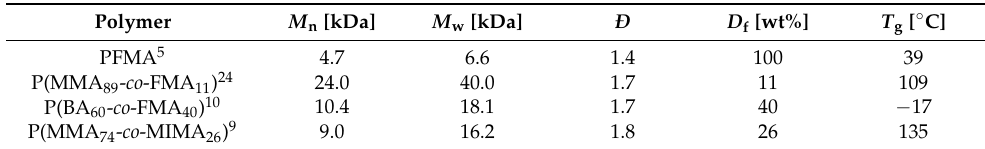
Table 1. Molecular weight ( M n / M w ), dispersity ( Ð ), degree of functionalization ( D f ), and glass transitions temperature ( T g , determined in the middle of the endothermic transition) of the three different furfuryl-bearing polymers and the maleimide-bearing